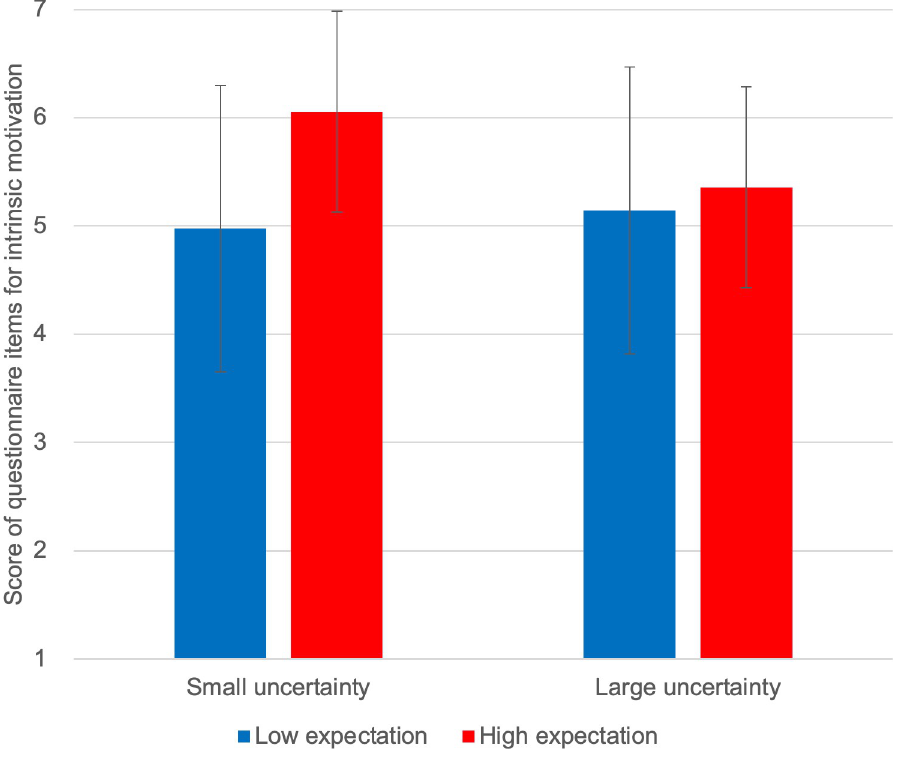
Fig 6. Self-reported intrinsic